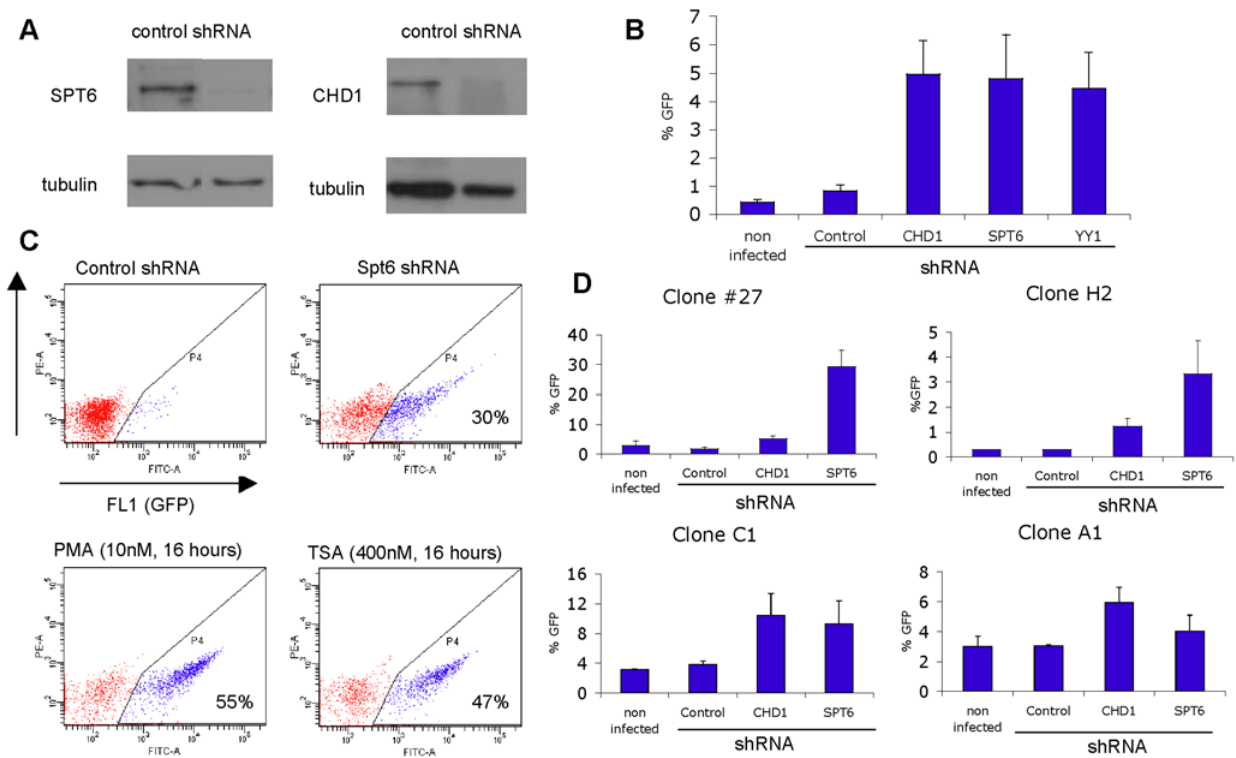
Figure 4. shRNA-mediated depletion of chromatin reassembly factors hSpt6 and hChd1 in Jurkat cells derepress latently- integrated HIV. (A) shRNA-mediated depletion of SPT6 and CHD1. A population of HIV (LTR-Tat-IRES-GFP-LTR) latently-infected human cells was infected with Control, Spt6 ( # 1, target sequence CGCCTTGTACTGTGAATTTAT) or Chd1 ( # 3, GCAGTTGTGATGAAACAGAAT) shRNA expression lentiviruses (pLKO.1-Puro) and, 10 days after puromycin (2 mg/ml) selection, depletion of these factors was tested in Western blot with specific antibodies and tubulin as a loading control. (B) HIV reactivation in a heterogeneous population of HIV latently infected Jurkat cells, expressed as percentage of cells that become GFP-positive 10–15 days after infection with the indicated shRNA-expressing lentiviruses and continuous selection with puromycin. Values represent the mean 6 SD of three independent infection experiments. (C) Example of FACS analysis of GFP expression as a result of HIV promoter reactivation in a latently infected Jurkat clone after infection with a Spt6 specific shRNA-expressing vector or treatment with PMA (10 nM for 16 h) or TSA (400 nM for 16 h). The percentage of GFP-positive cells is indicated inside the corresponding gate. (D) HIV reactivation in individual cell clones. Four different clones containing single HIV latent integrations previously mapped were infected with the indicated shRNA- expressing lentiviruses, selected by puromycin treatment, and GFP expression was monitored by FACS over time. Values represent the mean 6 SD of percentage of GFP-positive cells of two independent experiments 10–15 days after